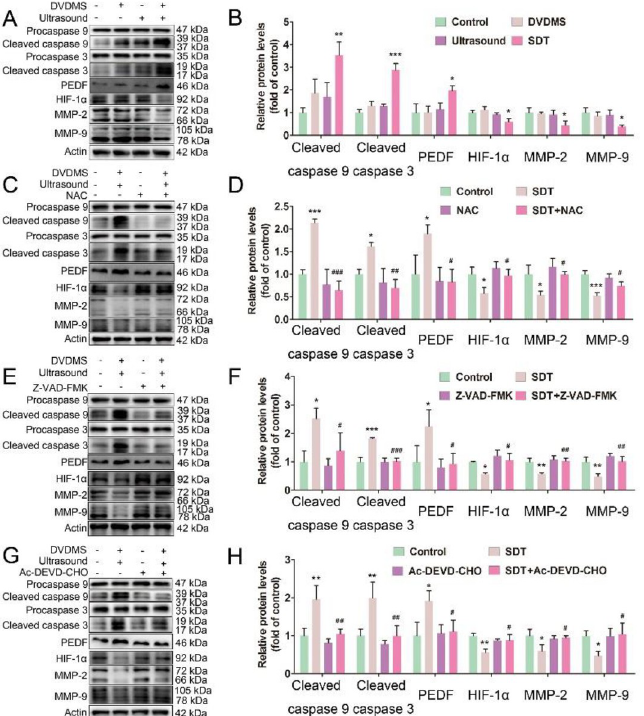
Fig 4. Sinoporphyrin sodium-mediated sonodynamic therapy (DVDMS-SDT) increases the protein level of PEDF and reduces the protein levels of HIF-1 α / MMP-2 / MMP-9 via mitochondria-caspase pathway in THP-1-derived foam cells. THP-1-derived foam cells were pre-treated with NAC, Z-VAD-FMK or Ac-DEVD-CHO for 1 h, followed by DVDMS-SDT treatment. At 6 h after treatment, the cells in the indicated groups were collected for western blot. (A, C, E, G) Immunoblotting of caspase 9, caspase 3, PEDF, HIF-1 α , MMP-2, and MMP-9 proteins levels, and (B, D, F, H) respective quantification. � P < 0.05, �� P < 0.01, ��� P < 0.001 vs. control. # P < 0.05, ## P < 0.01, ### P < 0.001 vs.